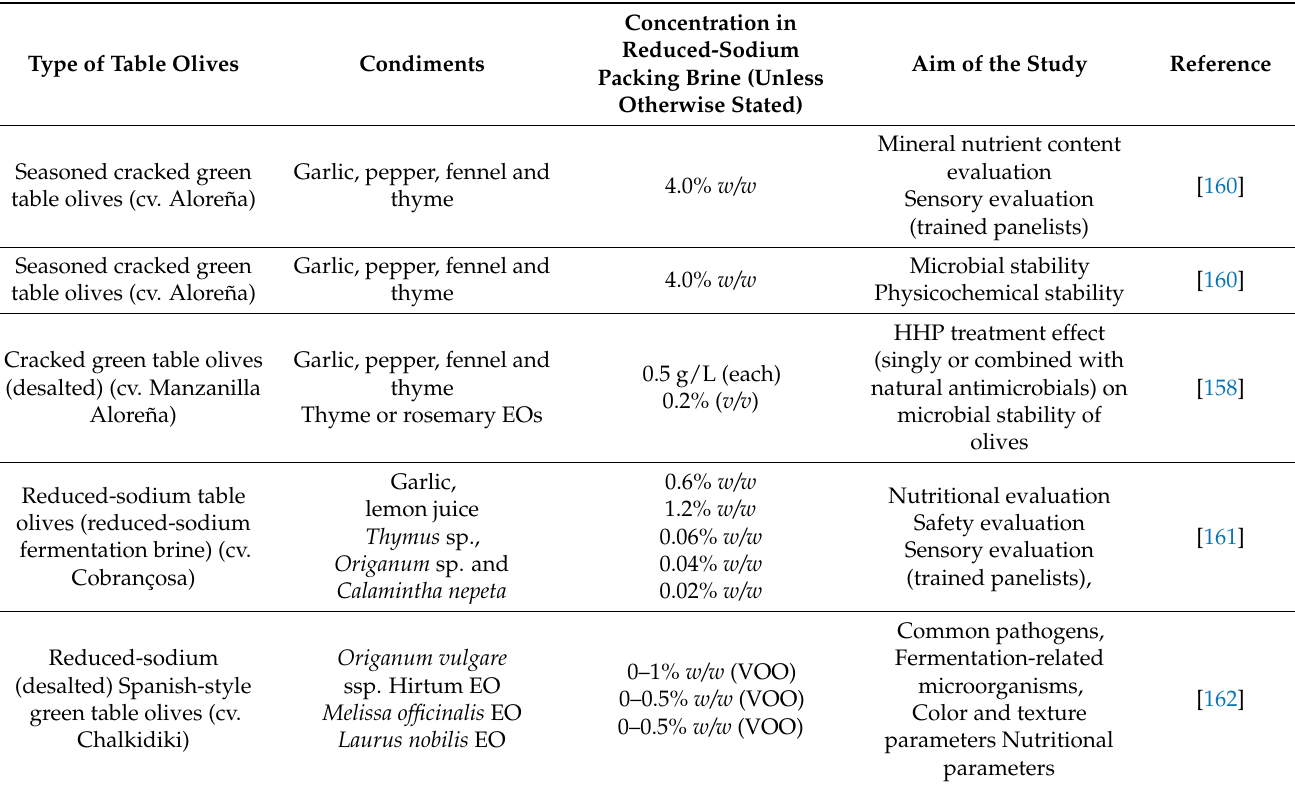
Table 8. Scientific publications including the terms “flavored” or “aromatized” or “aromatised” or “seasoned” and “table olive” in their title, abstract, or keywords, retrieved from Scopus on 3 February